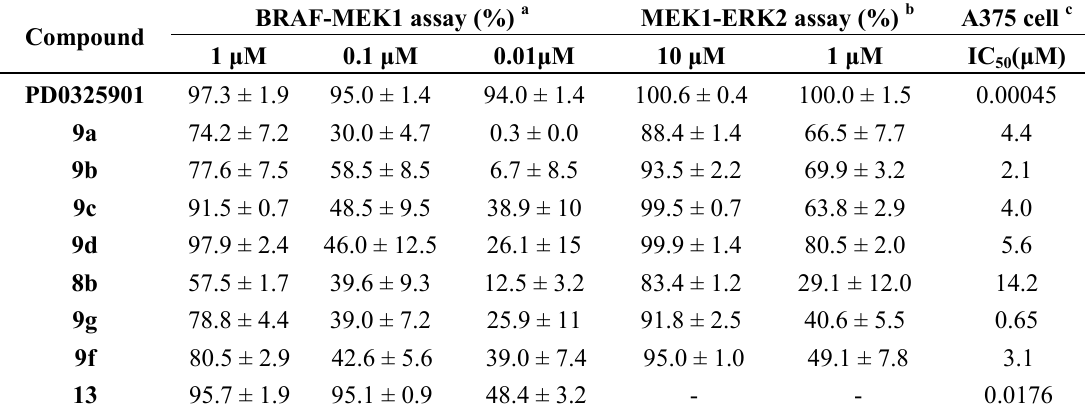
Table 1. HTRF phosphor-MEK1 assay and HTRF phosphor-ERK2 assay results